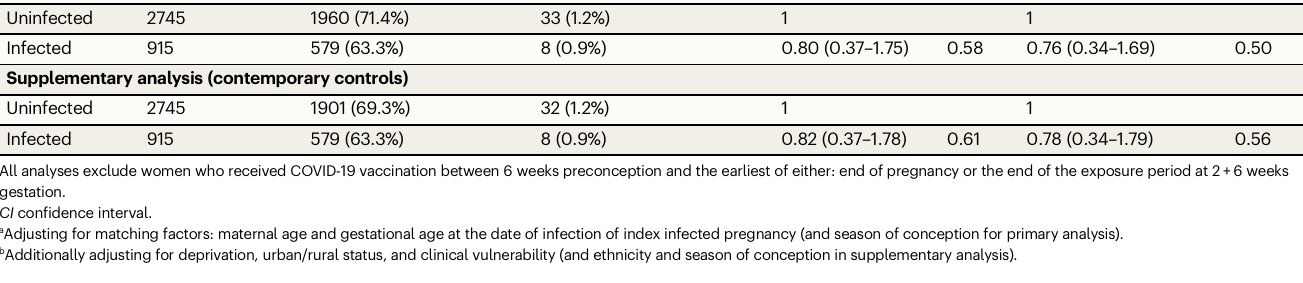
Table 5 | Odds ratios for the association between SARS-CoV-2 infection and ectopic pregnancy from multinomial logistic regression models Number of Number (%) of ongoing Number (%) of ectopic pregnancies pregnancies